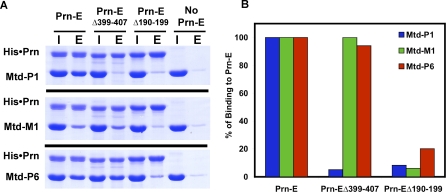
Dependency of Mtd Interactions on Major and Minor Pertactin Loops(A) Coprecipitation of 60 μM (trimer concentration) Mtd-P1 (top), Mtd-M1 (middle), and Mtd-P6 with His-tagged wild-type Prn-E, Prn-EΔ399–407, Prn-EΔ190–199, or no Prn-E using Ni2+-NTA beads and visualized by SDS-PAGE and Coomassie staining. I, relative amount incubated with Ni2+-NTA beads; E, relative amount eluted from beads.(B) Quantification of binding of Mtd-P1 (blue), Mtd-M1 (green), and Mtd-P6 (red) to Prn-EΔ399–407 and Prn-EΔ190–199, normalized by binding to Prn-E. Values were corrected for background binding (no Prn-E) to Ni2+-NTA beads.